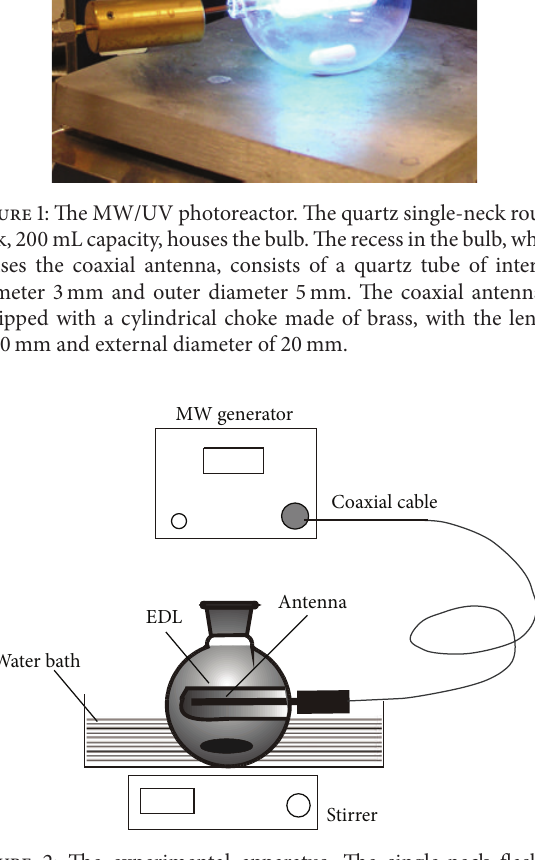
Figure 2: The experimental apparatus. The single-neck flask is soaked in a basin and is cooled by a water flow (pump and piping not shown, maximum flow of 1 L/min). The MW power is conveyed fromtheSairemgeneratortotheopencoaxialantennawithacoaxial cable of